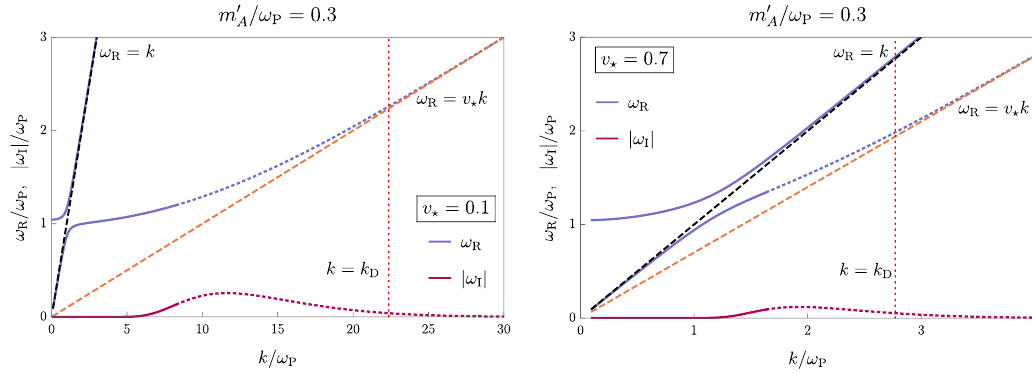
Figure 15. Plot of the two branches of the dispersion relations in a warm collisionless plasma for m A 0 = 0 . 3 ω p , using eqs. (D.8) and (D.12). We plot the dispersion relations for two typical electron gas velocities v ? = 0 . 1 and v ? = 0 . 7 . The slow (lower) branch asymptotes to the lines ω r = v ? k (dashed, orange) at large k . As the velocity of the gas increases, the slow branch moves closer to the light cone (dashed, black). In the opposite limit of a small velocity, the lower branch matches the cold plasma dispersion of appendix C.1 for k (cid:28) k d , namely it flattens out. Landau damping (red) becomes important for the slow branch around k d , as in the usual non-relativistic QED case [107] (the fast branch is not Landau damped as it lives only above the light cone). Past this point, we cannot trust our calculations and proceed in plotting the real part with a dotted line, as in [111]. For k (cid:28) m A 0 , ω p , thermal corrections do not affect the acoustic part of the slow branch that we are mostly interested